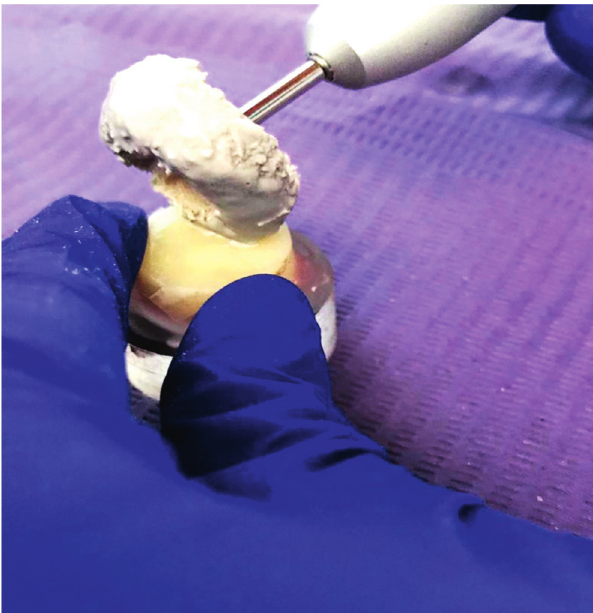
Figure 4: Polishing of polymethylmethacrylate blocks.